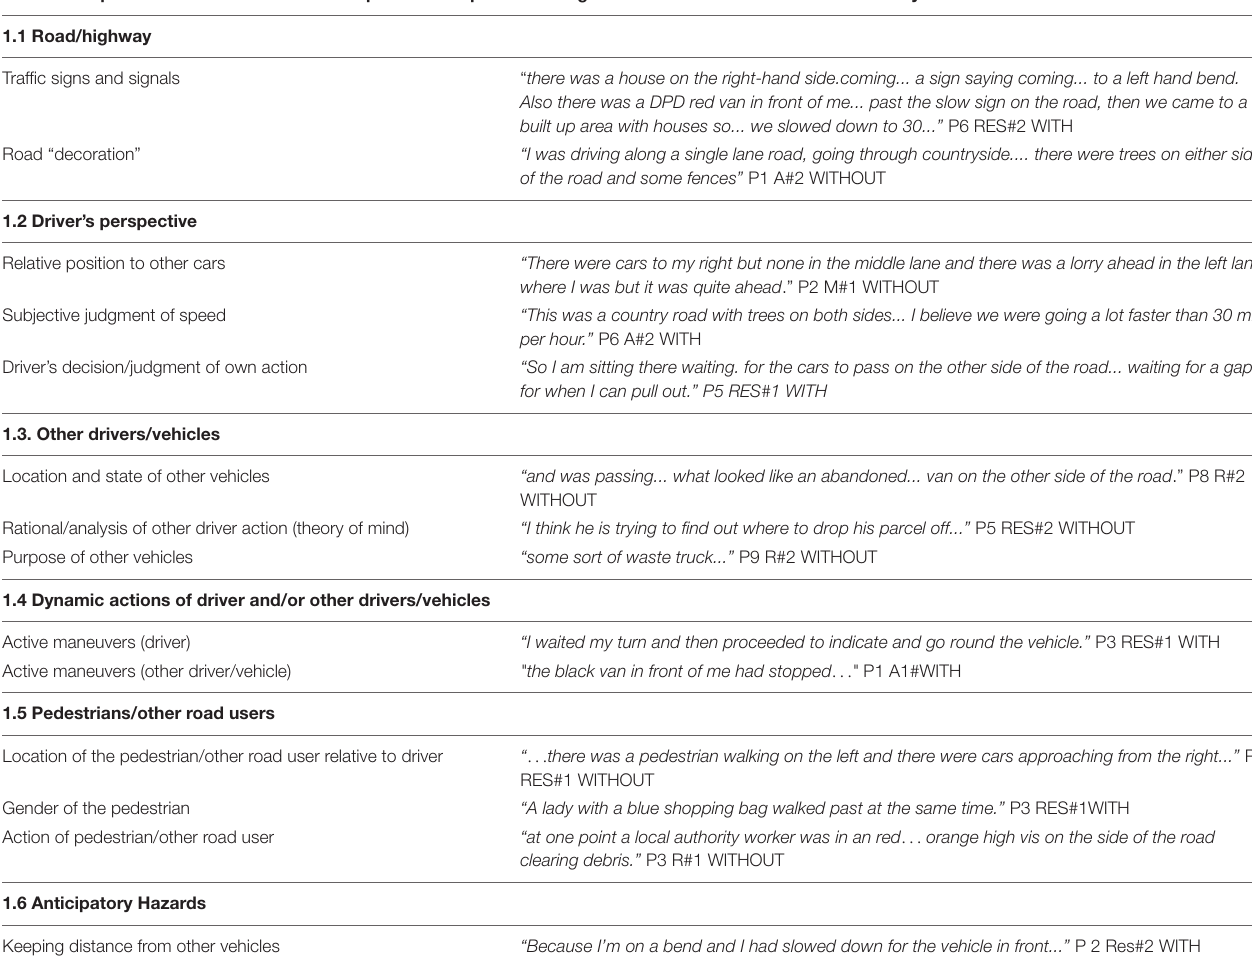
TABLE 5 | Examples of each theme with illustrative quotes from participant transcripts. Illustrative quotes derived from the SA Comprehension question categorized into sub-themes of the